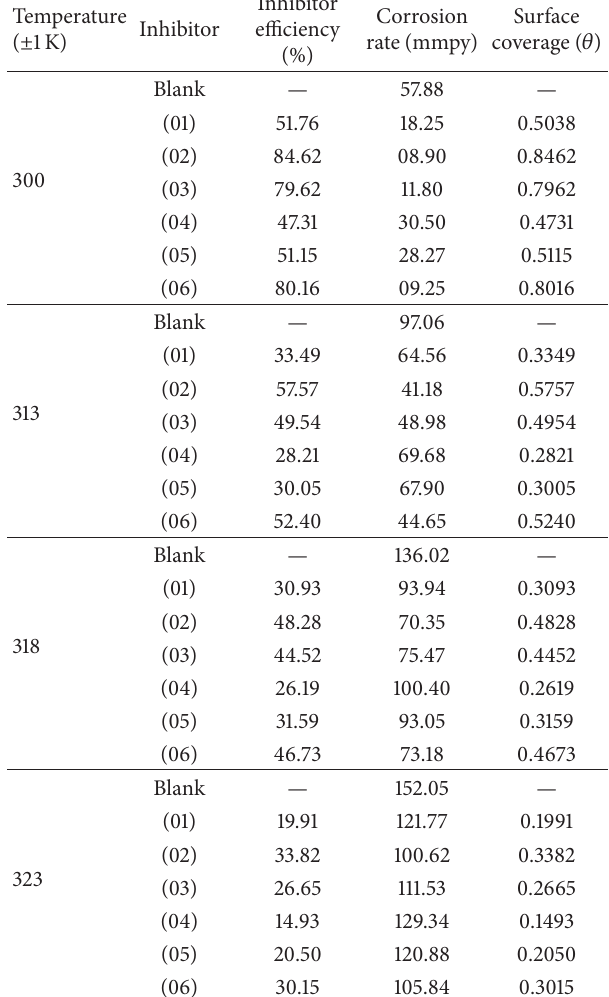
Table 1: Corrosion parameters for mild steel in 1N H the absence and presence of optimum concentration of variously substituted piperidin-4-ones (0.4 × 10 − 3 M) obtained from weight loss measurements at different temperatures.